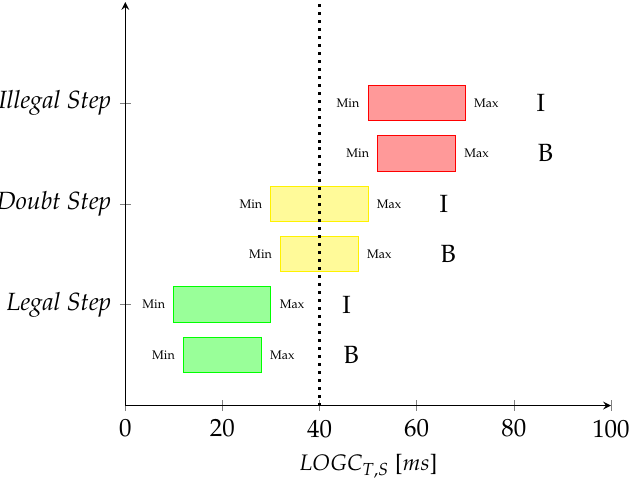
Figure 7. Three-levels step classification. On the x -axis, the values of LOGC T , S expressed in [ms]. On the y -axis, the classification of steps. Green, “legal” steps; yellow, “doubt” steps; red, “illegal” steps. I: inertial classification; B: benchmark classification (from the high-speed camera). The vertical dotted line represents the limit of human eye (LHE) value (fixed equal to 40